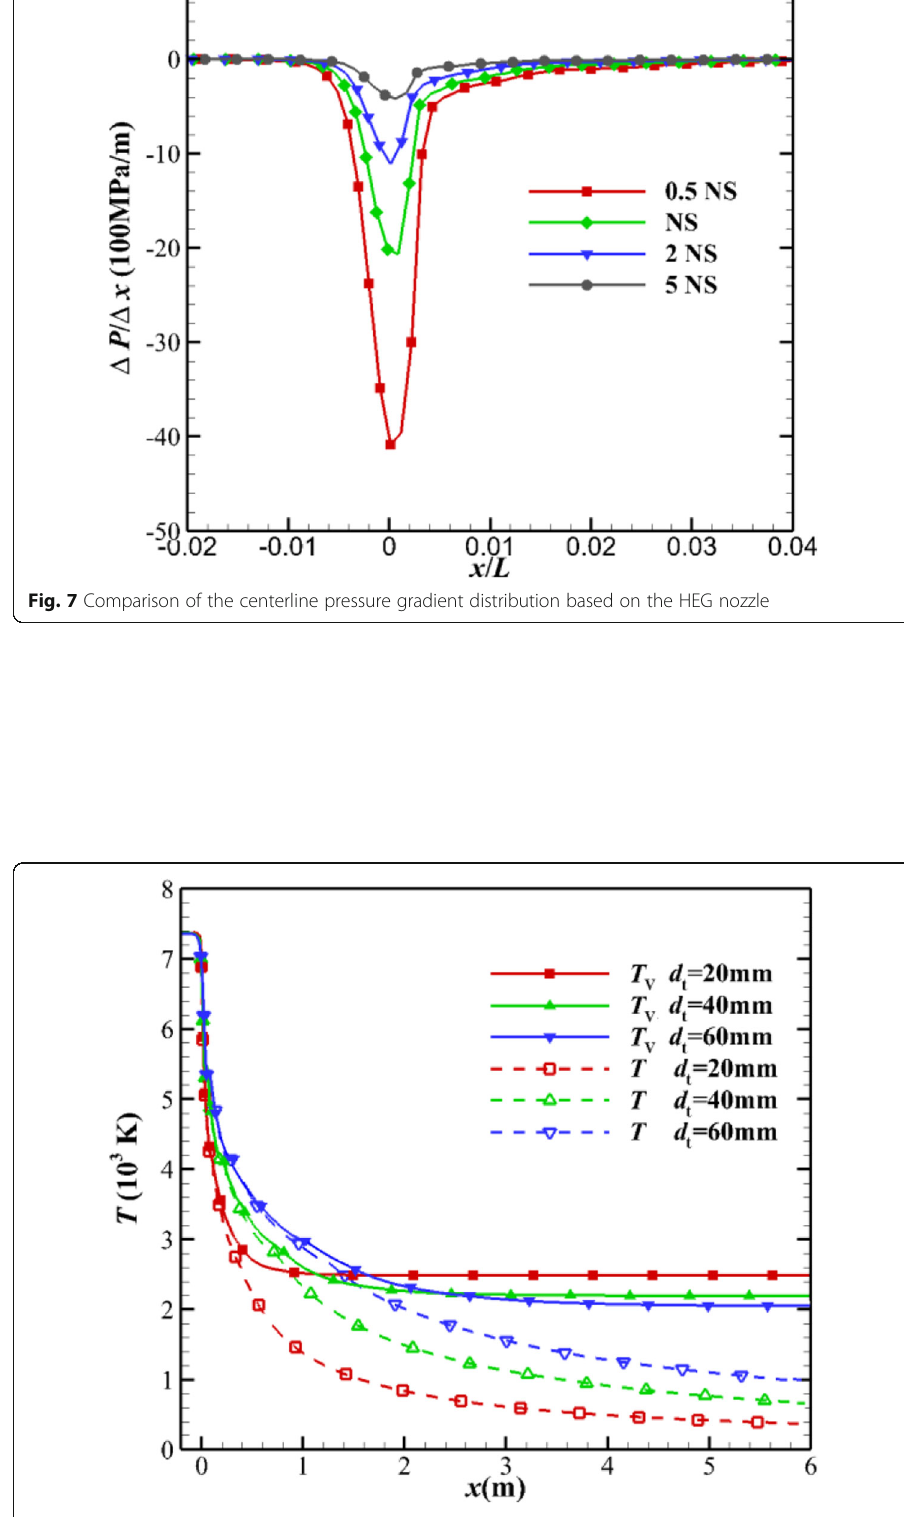
Fig. 8 Comparison of centerline temperature distributions based on the different throat